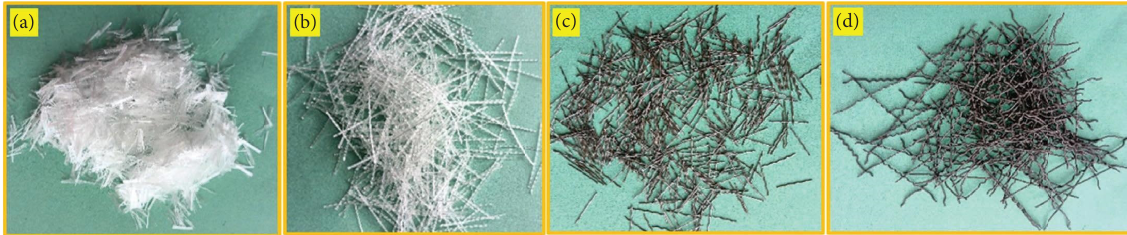
Figure 3: Te four distinctive fber appearances: (a) short PF, (b) long PF, (c) short SF, and (d) long SF.